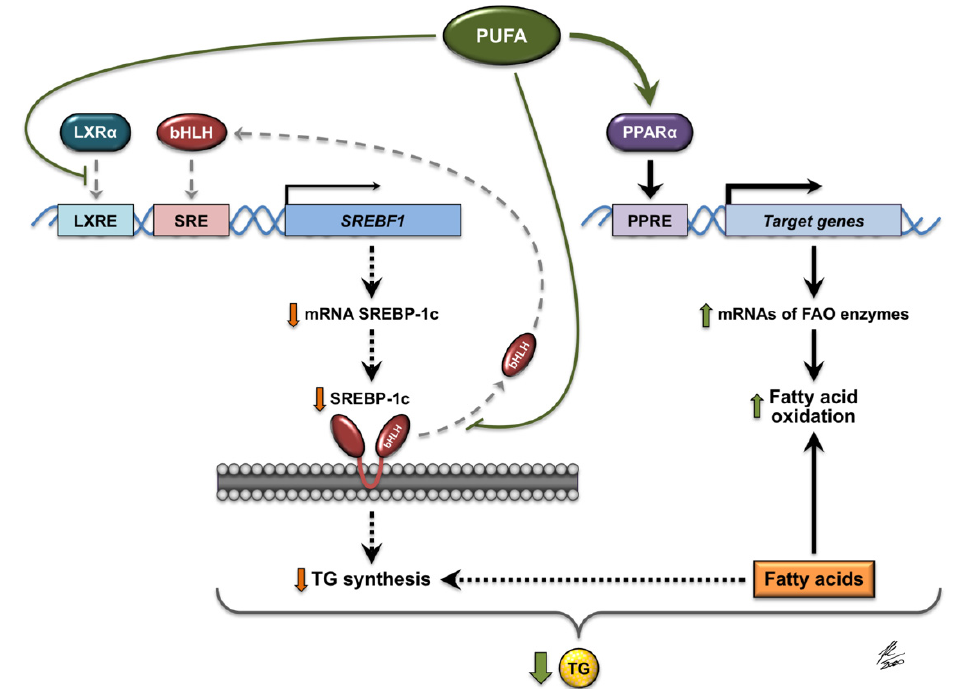
Figure 1. Molecular mechanisms involved in the regulation of gene expression by PUFAs (polyunsaturated fatty acids). PUFAs interfere with the binding of LXR α (liver X receptor α ) to DNA and decrease the expression of LXR α target genes, including the SREBF1 gene that encodes SREBP-1c (sterol regulatory element-binding protein 1c). Moreover, PUFAs inhibit the proteolytic release of the active form of SREBP-1c (bHLH, basic helix-loop-helix) from the membranes of the endoplasmic reticulum, thus preventing the translocation of this transcription factor to the nucleus. The expression of genes activated by SREBP-1c, such as SREBF1, and the genes associated with the synthesis of fatty acids and TGs (triglycerides), is therefore diminished. PUFAs also act as natural ligands that activate PPAR α (peroxisome proliferator-activated receptor α ), which in turn induces the expression of its target genes, such as those encoding the enzymes involved in hepatic oxidation of fatty acids. JK/2020: Author’s signature.